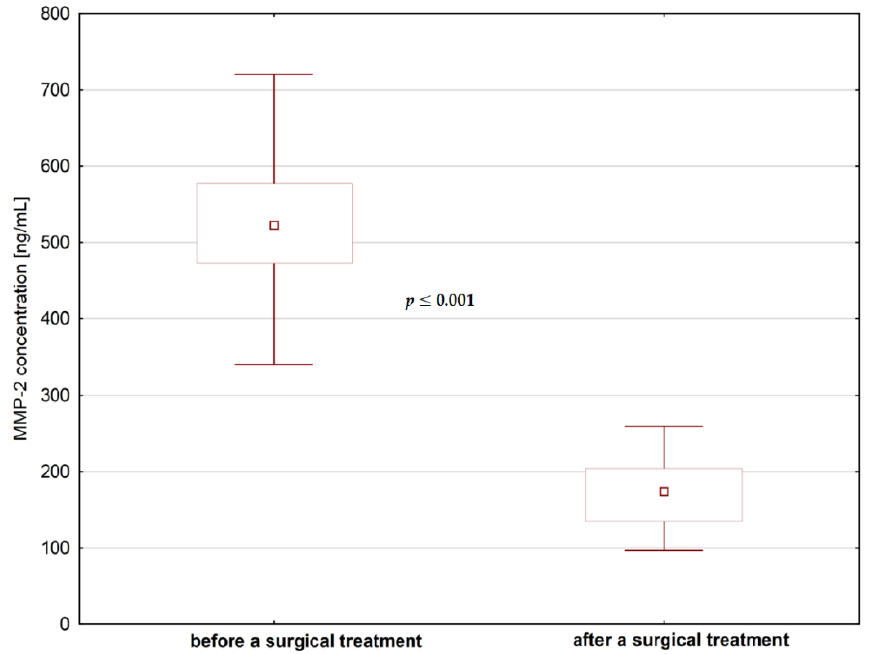
Figure 5. The concentrations of MMP-2 in saliva before and after surgical treatment.